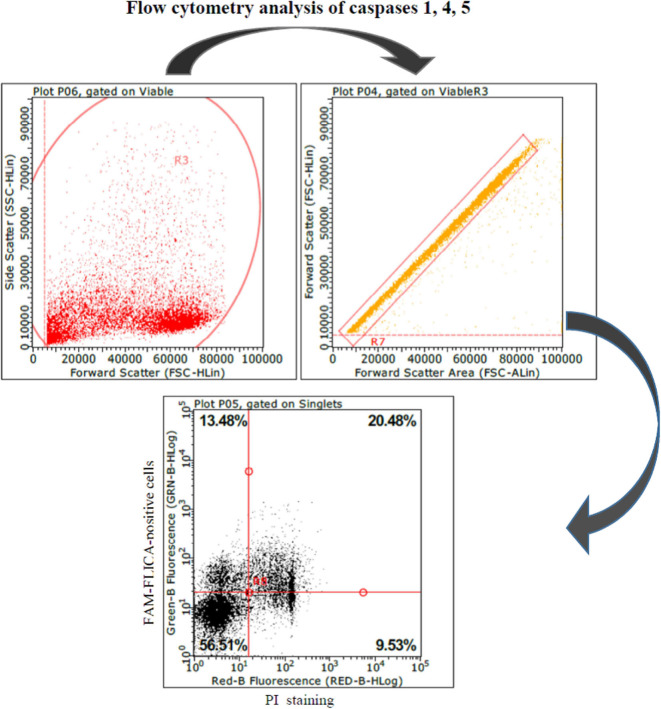
Swine PBMCs were stained with the FAM-FLICA YVAD probe. After the final washing, cells were stained with propidium iodide and gated by a combination of forward and side scatter (FSC vs. SSC). Next, doublet and multiplet cells were discriminated from single cells in a FSC height/FSC area cytogram. Single cells were gated to a quadrant cytogram, depicting caspase-positive cells in the y-axis, and dead (late apoptotic and necrotic) cells in the x-axis.